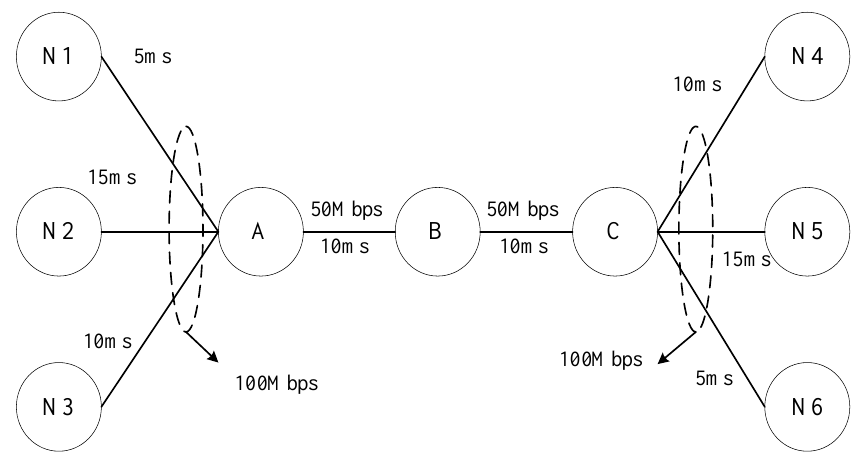
Figure 6. Simulation topology.